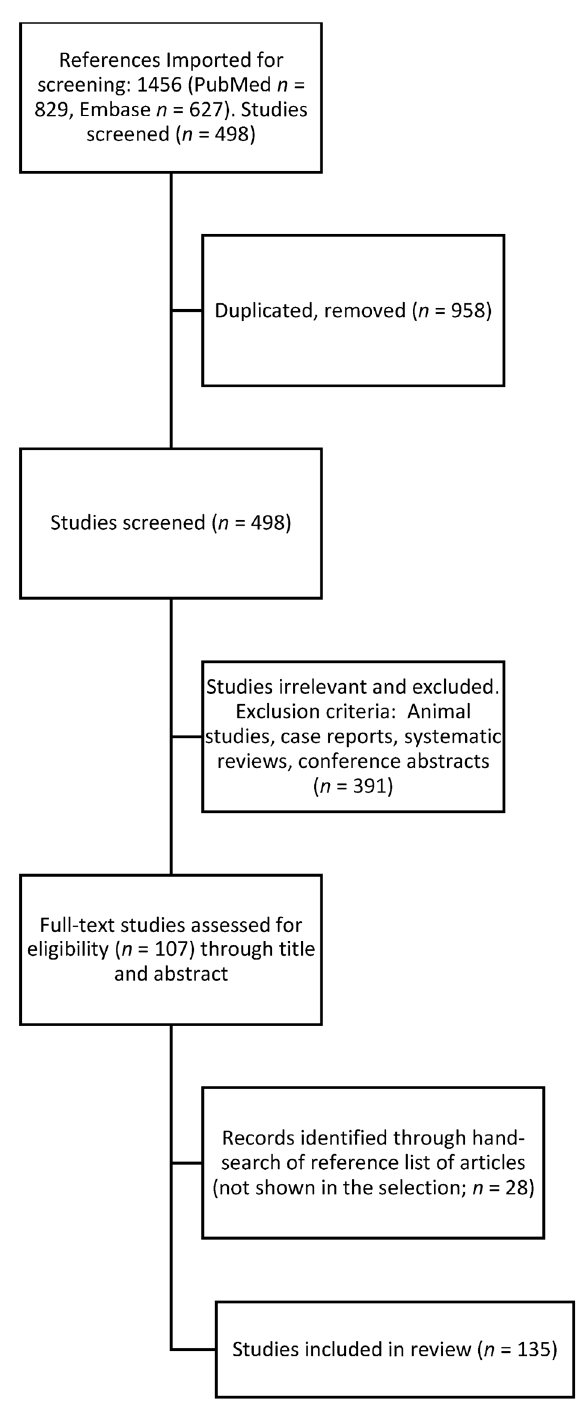
Figure 2. Flow chart explaining the literature selection. A systematic review was performed following PRISMA guidelines. A total of 1456 records were selected (829 in PubMed and 627 in Embase),